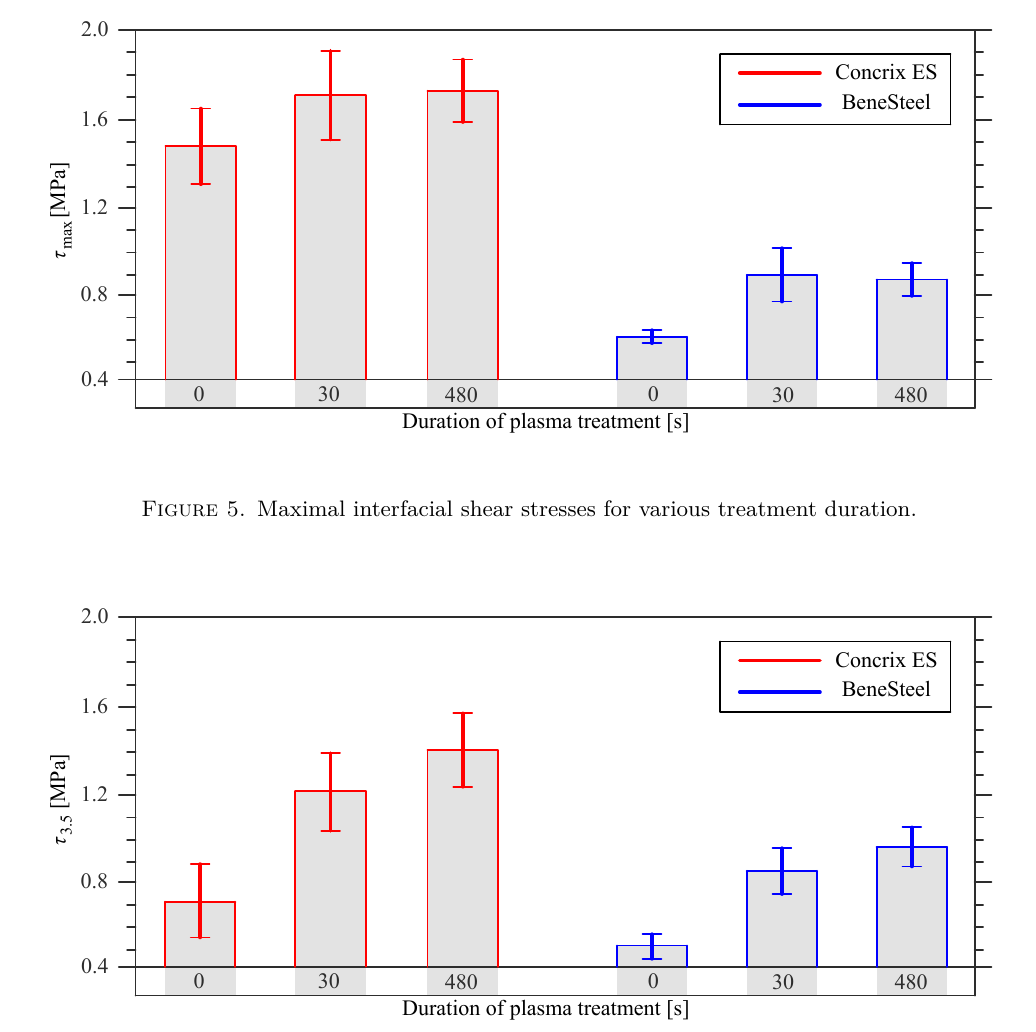
Figure 6. Interfacial shear stresses at 3.5 mm pullout for various treatment